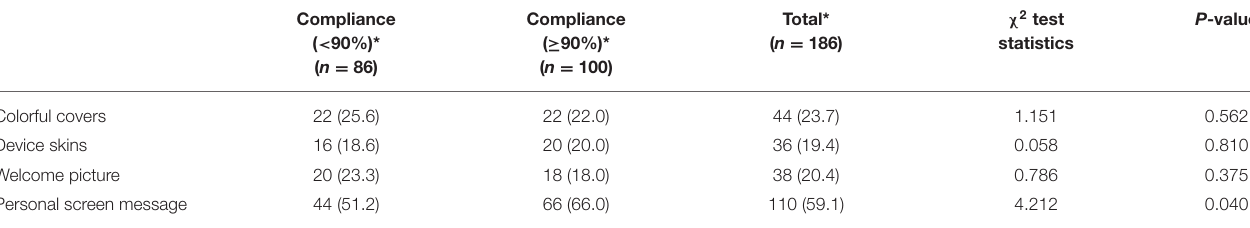
TABLE 3 | Comparison between compliance groups for the preferred personalized device features ( N =